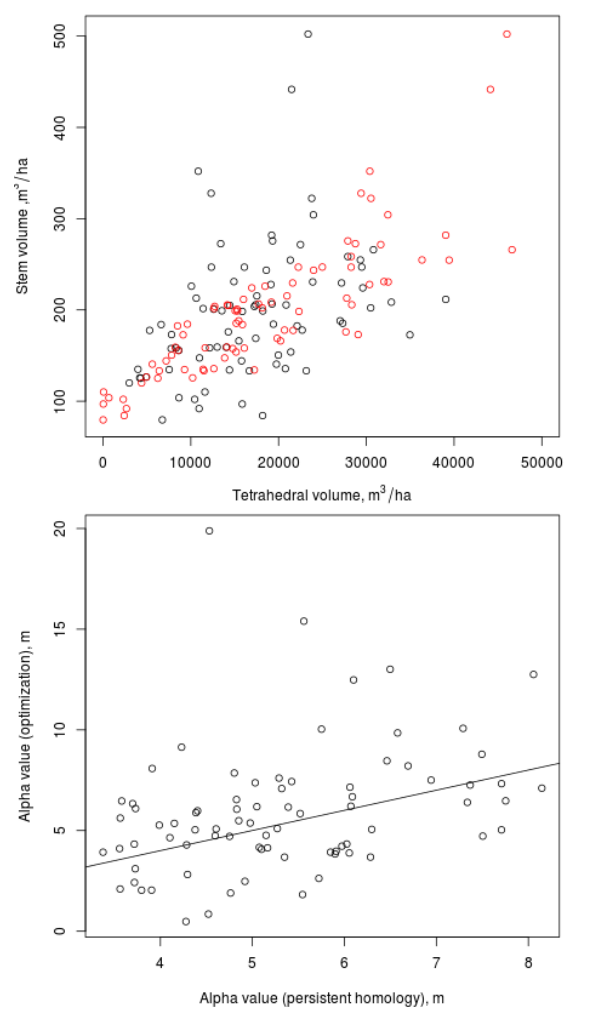
Figure 3. Above: the relationship of the canopy volume (persistent homology – black circles, optimization – red circles) with the plot-level stem volume. Below: the correspondence of the α values obtained by the two approaches.